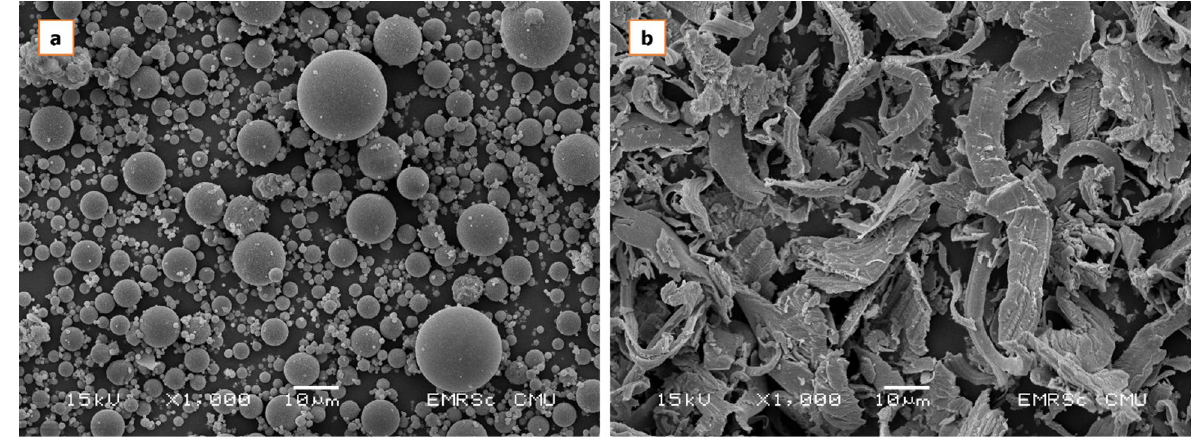
Figure 1. SEM microphotographs of ( a ) FA and ( b ) WIP at 1000 × magnification.